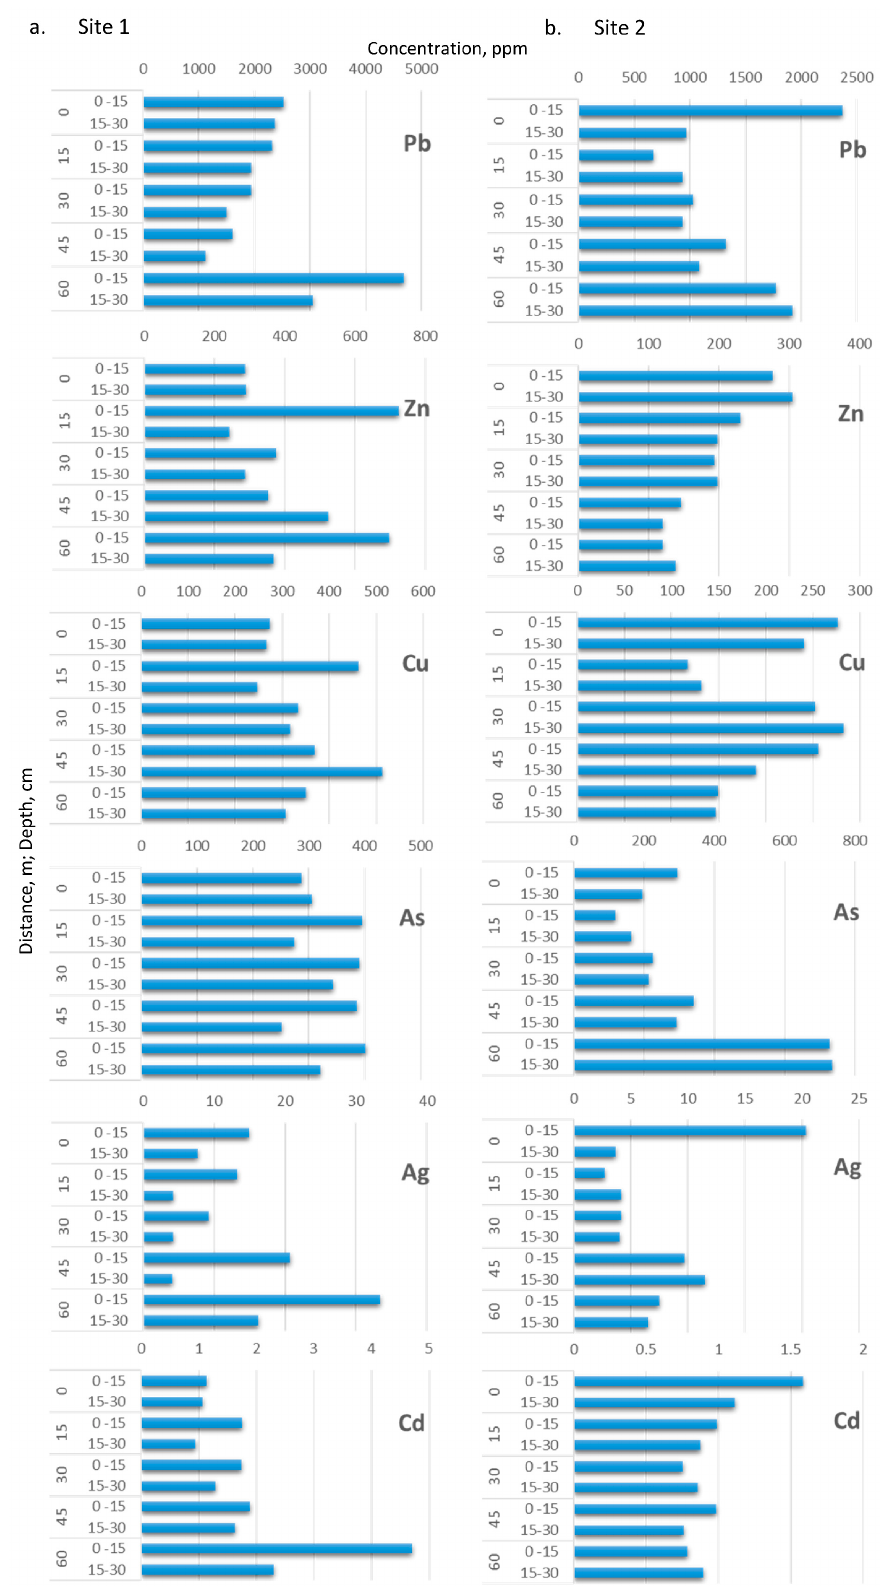
Figure 2. Soil Pb, Zn, As, Cu, Ag, and Cd concentration (mg kg − 1 ) for five distances (0–60 m) ant two depths (0–15 and 15–30 cm) in site#1 and site #2 from Hualgayoc district, Cajamarca region,